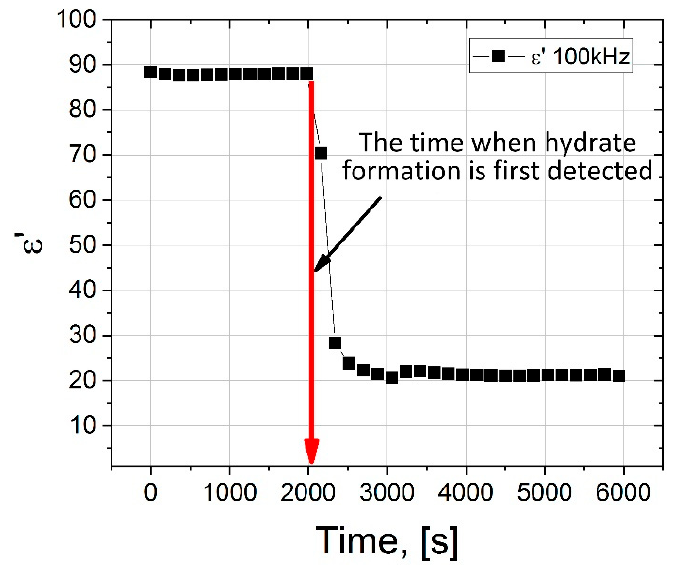
Figure 7. Dependence of ε ’ on the time of the experiment on the formation of the hydrate (273 K, 9 MPa). The ε ’ values are taken for a frequency of 10 5 Hz. The process of gas hydrate growth under static conditions (at constant temperature and pressure) takes a long time since it is associated with the diffusion restrictions